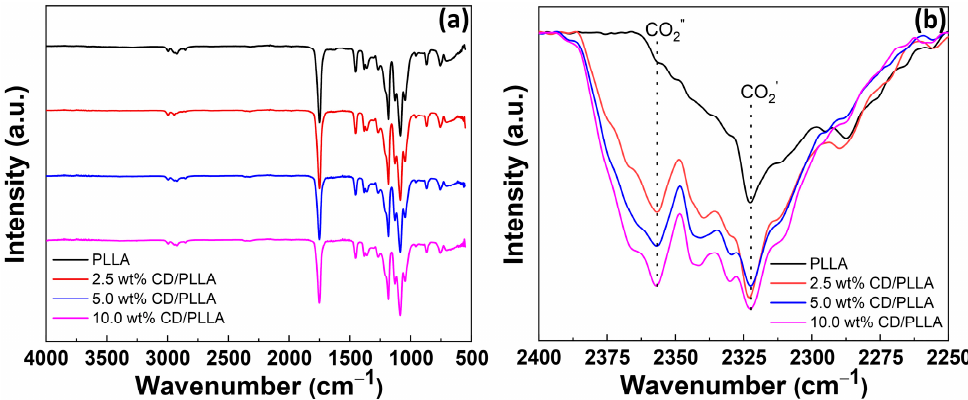
Figure 2. ( a ) FTIR spectra of electrospun PLLA, 2.5 wt % CD/PLLA, 5 wt% CD/PLLA, and 10 wt% CD/PLLA and ( b ) Expanded FTIR